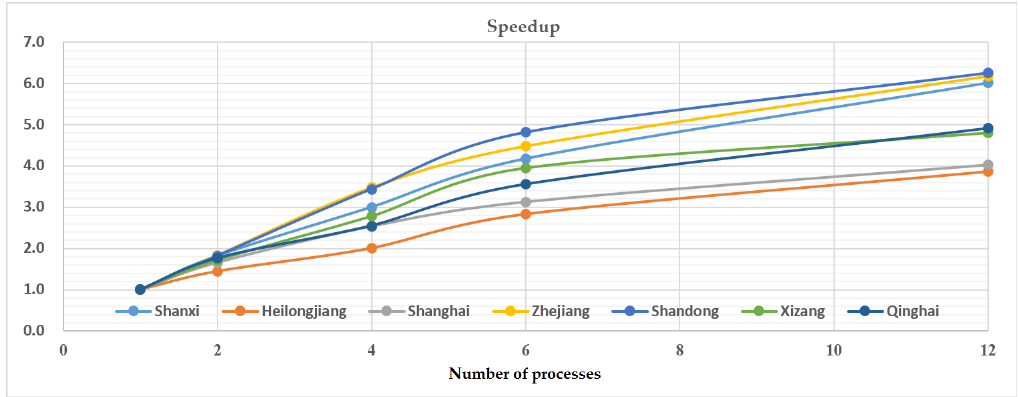
Figure 12. Performance improvement in different numbers of processes.